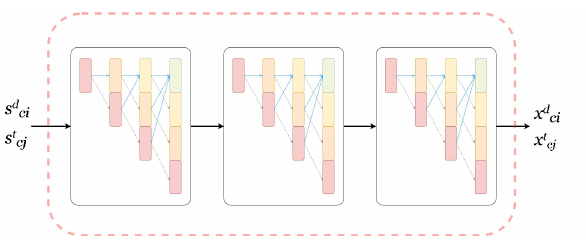
Fig. 3 Details and data calculation of the three DCBs. s d and s t are source one-hot matrics for drug and target, cj respectively.